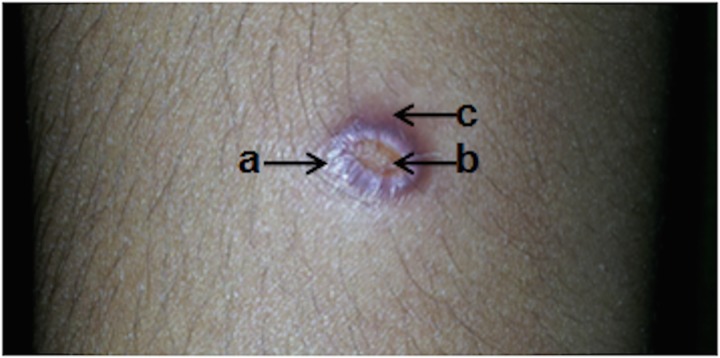
An ulcerating skin nodule surrounded by an erythromatous reaction in the upper limb of the CL patient. Commonest presentation (n = 80/250, 32%) of cutaneous leishmaniasis patients included in the study. (a) Nodular area; (b) central ulceration: (c) surrounding skin with erythromatous reaction.